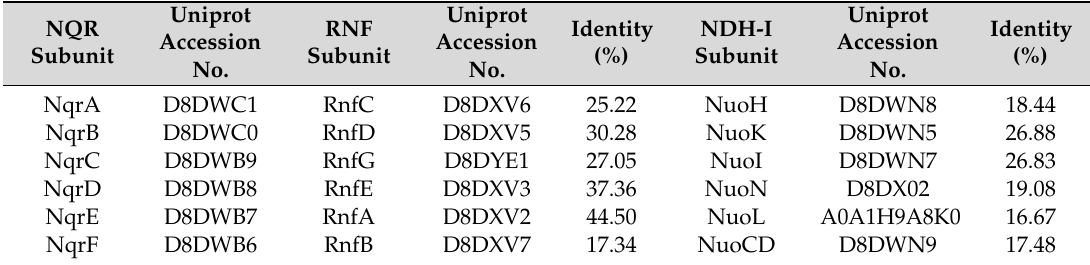
Table 3. Sequence identities inferred from multiple sequence alignments of the NQR subunits with the corresponding subunits of the RNF complex and the most similar subunits of the NDH-I (Nuo). Alignments were performed with Clustal Omega (European Bioinformatics Institute, ebi.ac.uk / Tools / msa / clustalo /